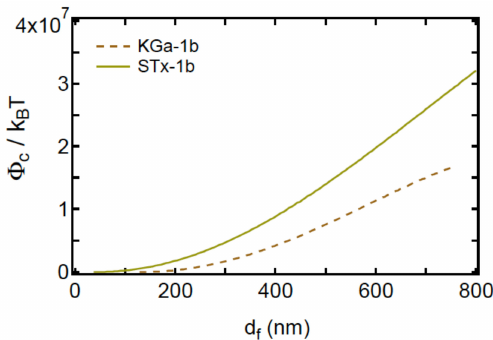
Figure 6. E ff ect of the distance d f that a retained colloid protrudes a thin water film on the capillary potential energy, Φ c , for clay colloids KGa-1b and ST x